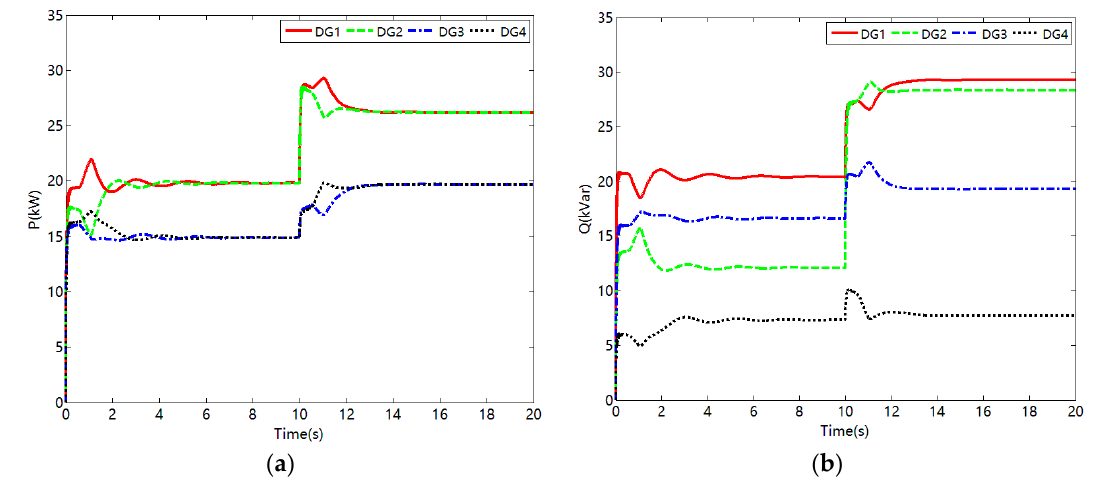
Figure 11. Simulation results with time-delays. ( a ) Active power; ( b ) reactive power.